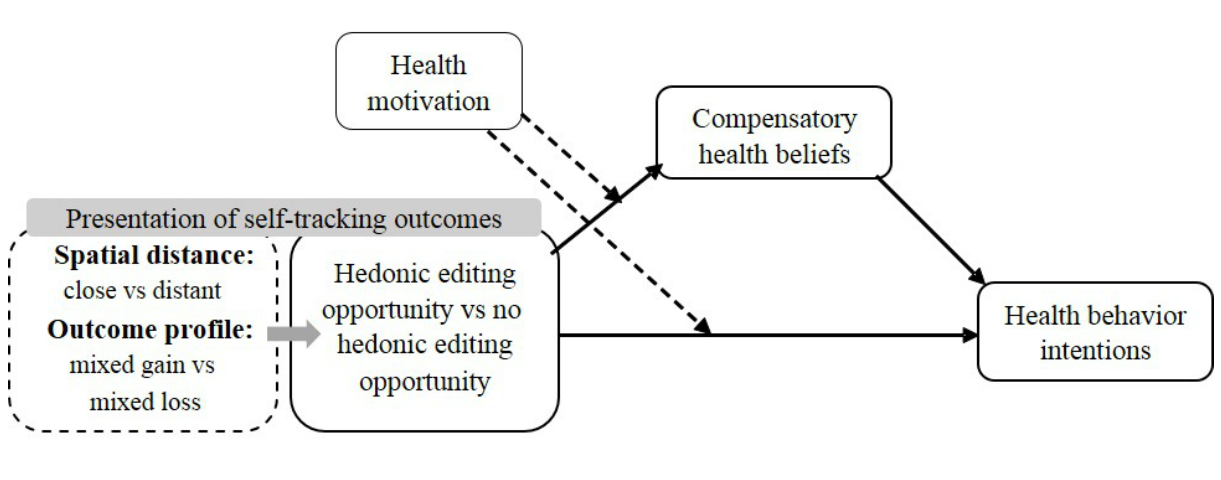
Figure 1. Proposed model of how hedonic editing opportunity as a function of spatial distance and self-tracking outcome profile influences users’ health behavior intentions. The self-tracking outcome profile is a mixed gain if there is a positive outcome in one domain and a smaller negative outcome in the other domain. Conversely, in a mixed-loss outcome profile, there is a large negative outcome in one domain and a smaller positive outcome in the other